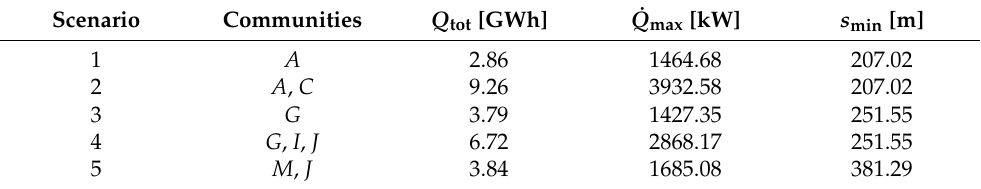
Table 3. Specified separation scenarios of the FZJ district heating system.